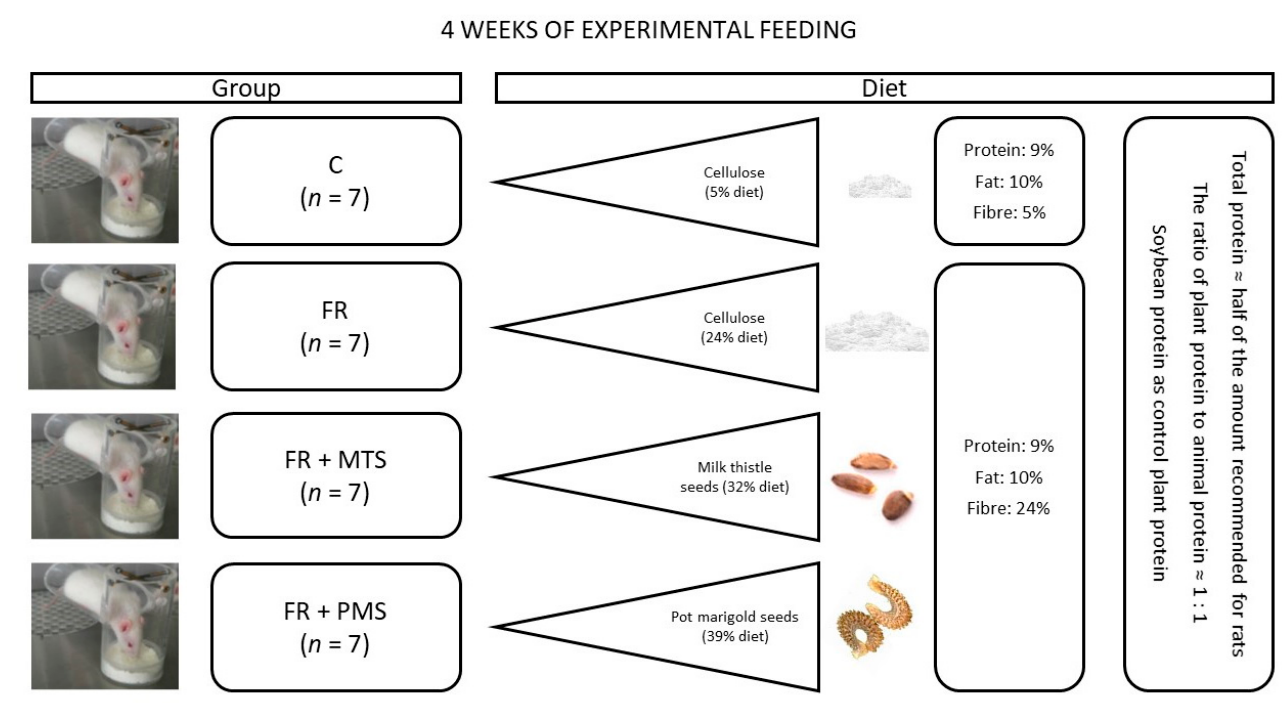
Figure 1. Scheme of experimental design. C, control group fed a diet containing soy protein isolate; FR, positive control group fed a fibre-rich diet containing soy protein isolate; FR + MTS, experimental group fed an FR diet containing milk thistle seeds; FR + PMS, experimental group fed an FR diet containing pot marigold seeds. group, which indicates that the diet fed to the FR + MTS group was less palatable. Com- pared with the FR group, the final body weight and body weight gain were lower in the FR + PMS group, which also translated into lower gains of body fat mass, lean mass and free fluids in this group. However, the initial and final percentages of body fat mass, lean mass and free fluids did not differ between the C and FR groups or among the FR groups. Table 1. Dietary intake, body weight and body composition of rats after 4 weeks of feeding with a fibre-rich (FR) diet containing milk thistle seeds (MTSs) or pot marigold seeds (PMSs) 1 .